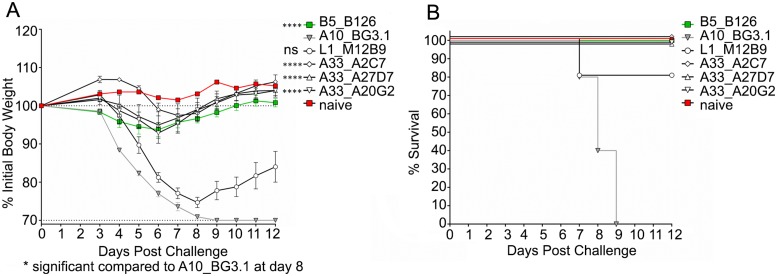
Protection of Balb/c mice from VACVWR by anti-A33 mAbs.Antibody protection against weight loss (A) and mortality (B) caused by VACVWR challenge. All analyzed anti-A33 MAbs protect both against weight loss and death. One of two independent experiments is shown. Significance for all A33 antibodies (****) was P<0.0001, while the anti-L1 control antibody M12B9 was not significant (ns) with P = 0.1577. The negative control antibody A10 provided no protection as expected, while the positive control anti-B5 antibody B126 conferred protection. (B) Note that slight shifts on the Y-axis were implemented for visualization purposes for all antibodies that confer full protection.